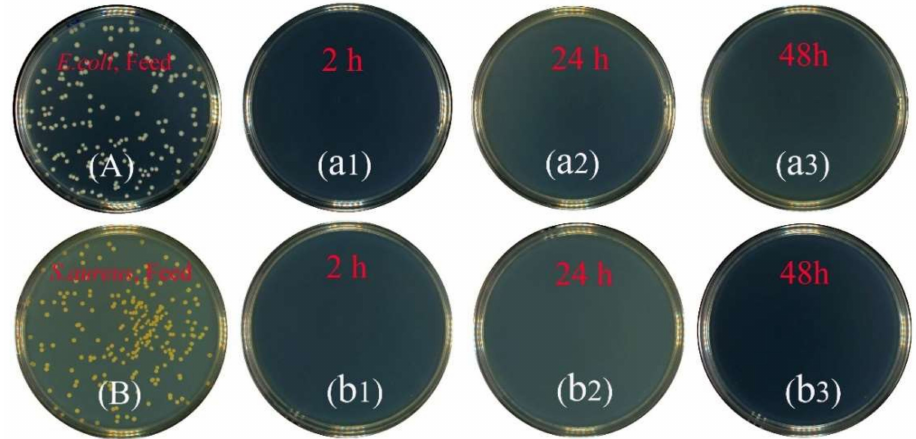
Figure 8. Digital images of plaque forming unit (PFU) results. The feed containing Escherichia coli ( E. coli , ( A )) and Staphylococcus aureus ( S. aureus , ( B )); the filtrate after different treatment times of 2 h, 24 h, and 48 h for E. coli ( a1 – a3 ) and S. aureus ( b1 – b3 ).